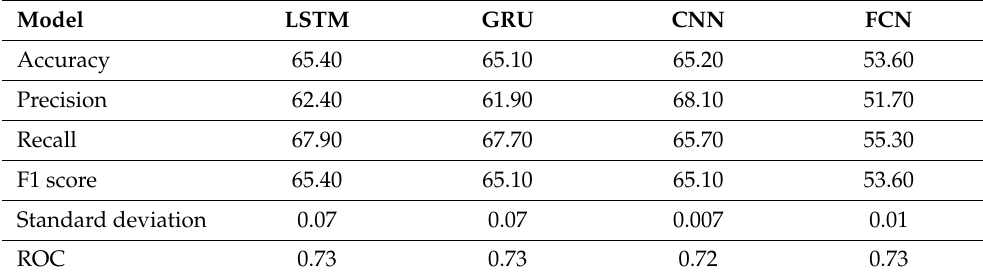
Table 13. Results of deep learning models.